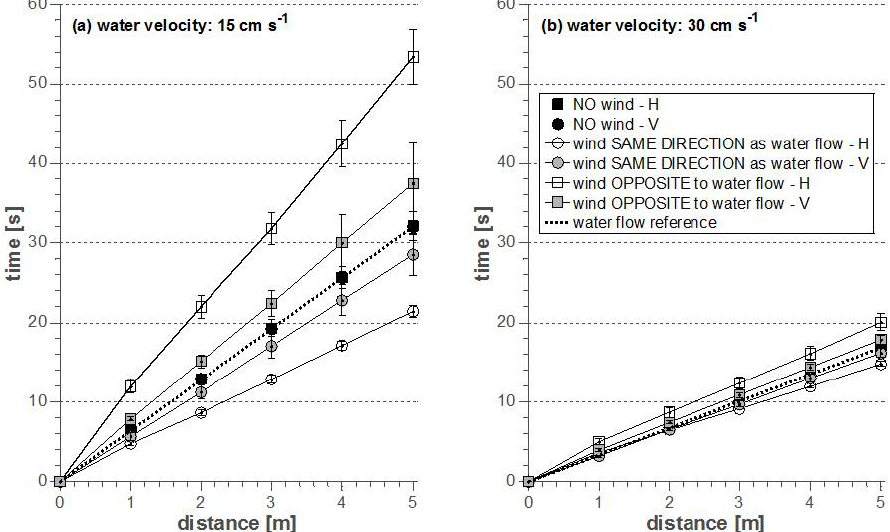
Fig. 4. Dispersal velocity profile of horizontally (open symbols, H) and vertically (grey symbols, V ) floating Ceriops tagal propagules, for the S-scenario (circles), O-scenario (rectangles) and for the scenario in which was not considered (black symbols). The water flow velocity (dotted line) is added as a reference. All wind scenarios were tested using a water flow velocity of 15cms − 1 (a) , and 30cms − 1 (b) . Vertical bars indicate standard